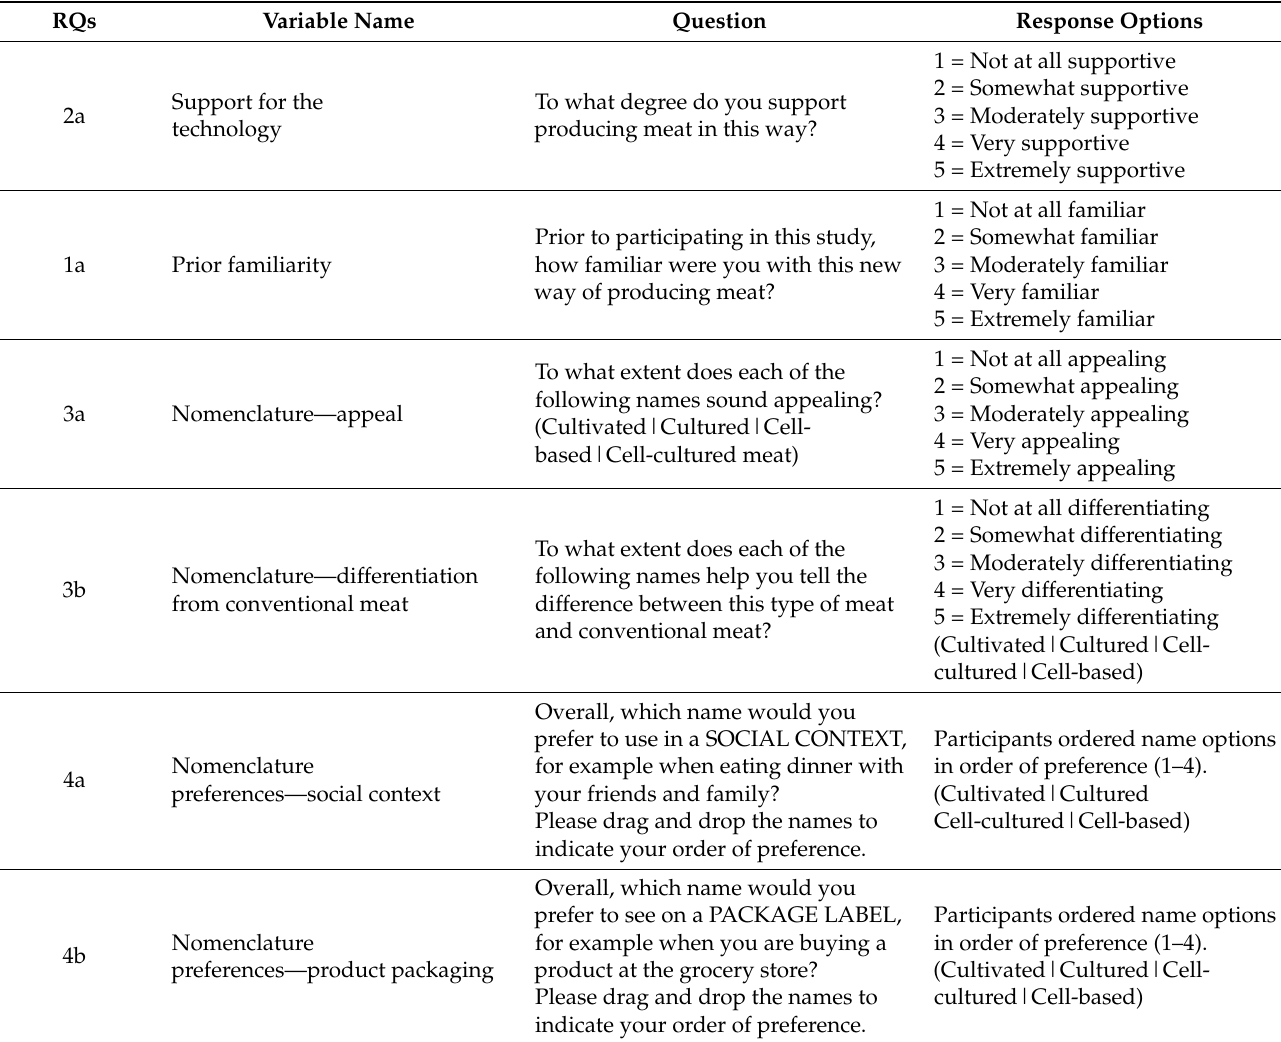
Table 2. Brief technology description outcome